Question: Write the caption for this figure.
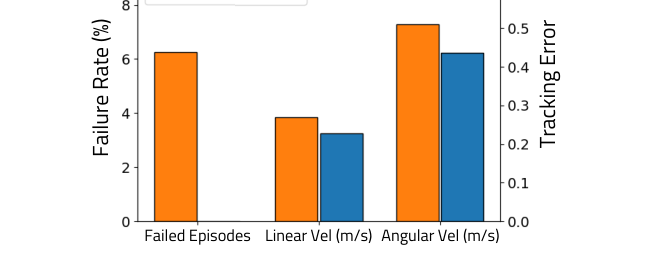
Answer: Comparison of failure rates and tracking errors between DL w/o Goal and DiffuseLoco (ours) in simulation. The left y-axis is the metric for Failed Episodes. The right y- axis indicates the tracking error for linear velocity and angular velocity.